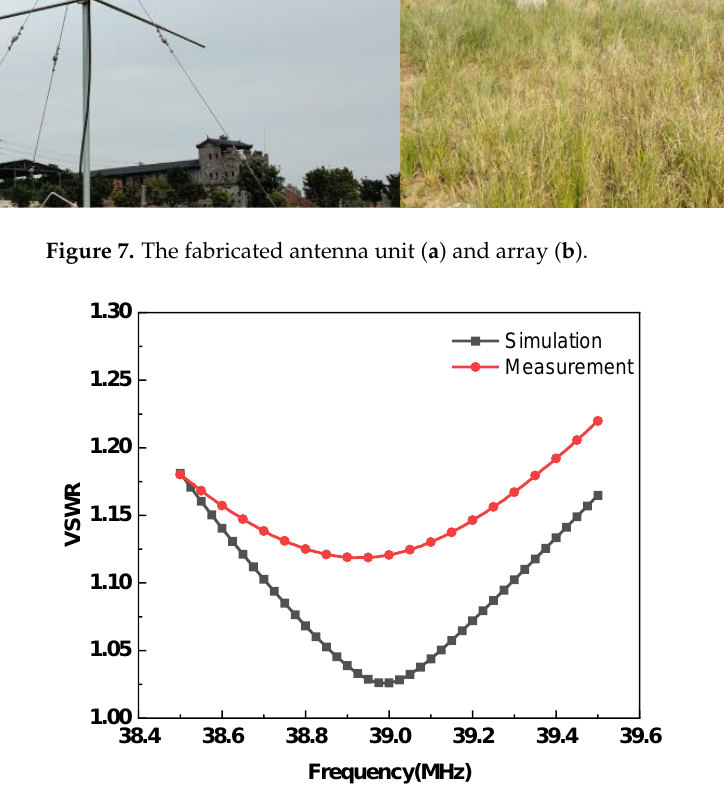
Figure 8. Comparison of VSWR measurement results and simulation results.